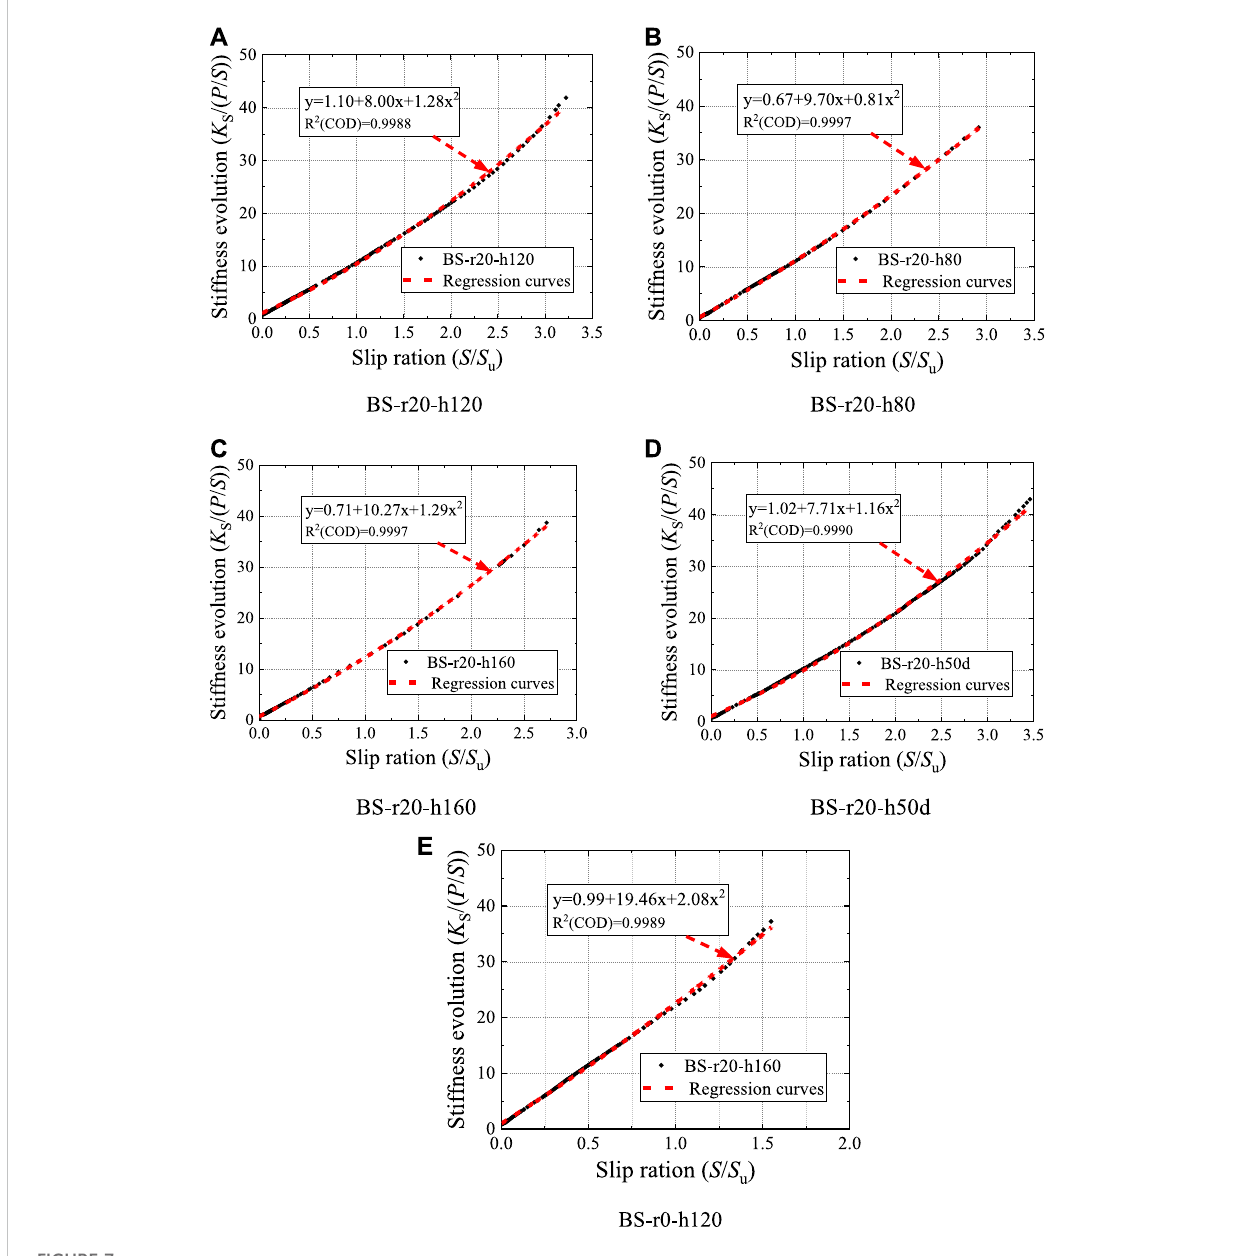
Stiffness evolution of specimens. (A) BS-r20-h120 (B) BS-r20-h80 (C) BS-r20-h160 (D) BS-r20-h50d (E)